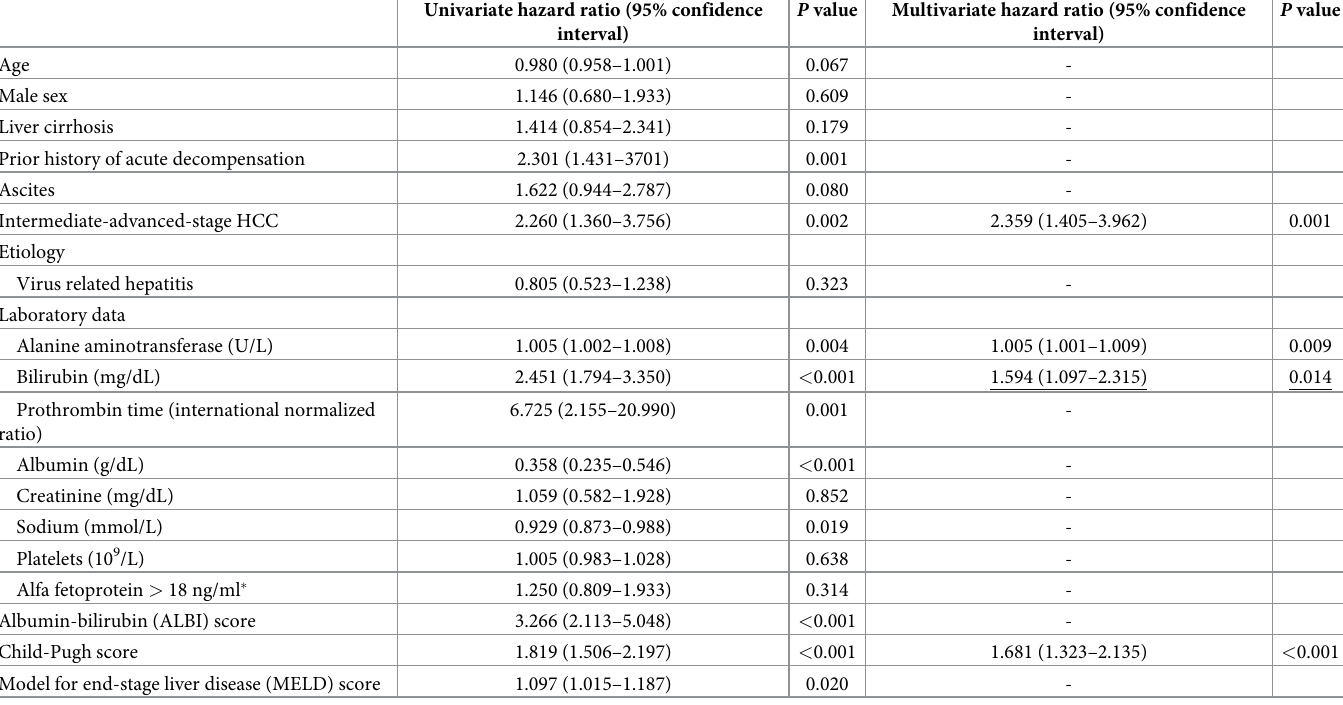
Table 5. Cox regression analyses of predictive factors for the development of acute decompensation in the chemoembolization